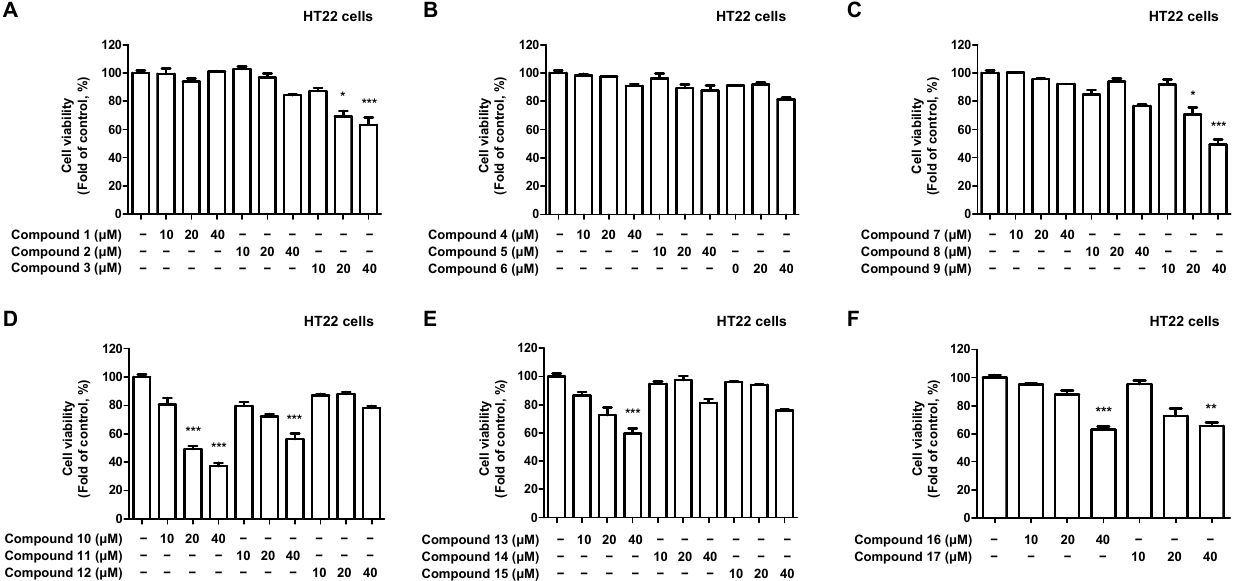
Figure 4. Effect of the 17 natural compounds isolated from C. longa on the cytotoxicity in HT22 hippocampal cells. ( A – F ) Cytotoxicity was evaluated in cells treated for 48 h with 10–40 µM of compounds 1–17. Data are presented as the mean ± SD values of 3 independent experiments. * p < 0.05, ** p < 0.01, and *** p < 0.001 compared with control.